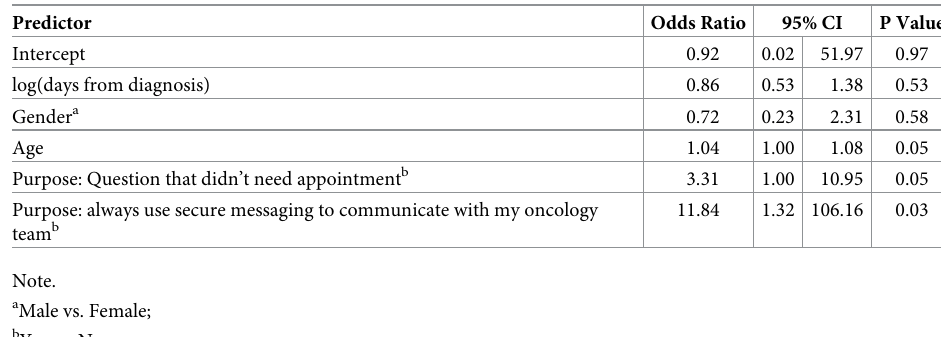
Table 4. Predictors of secure message